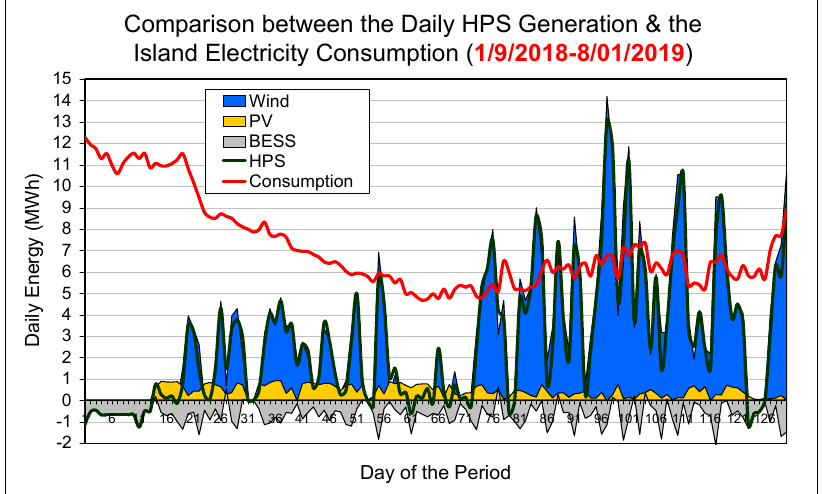
Figure 22. The daily energy balance analysis for Tilos island.